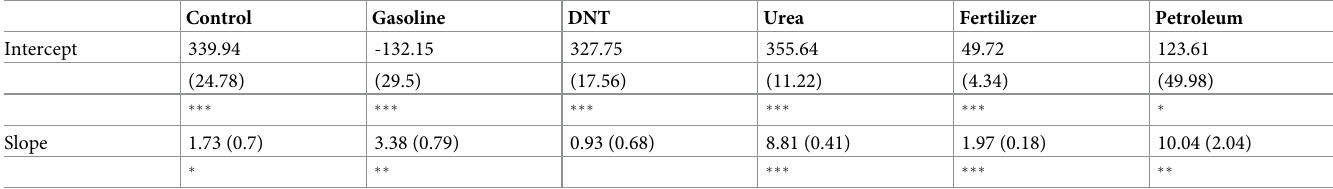
Table 3. This table contains LME model parameters for six LME models (defined in the methods section).